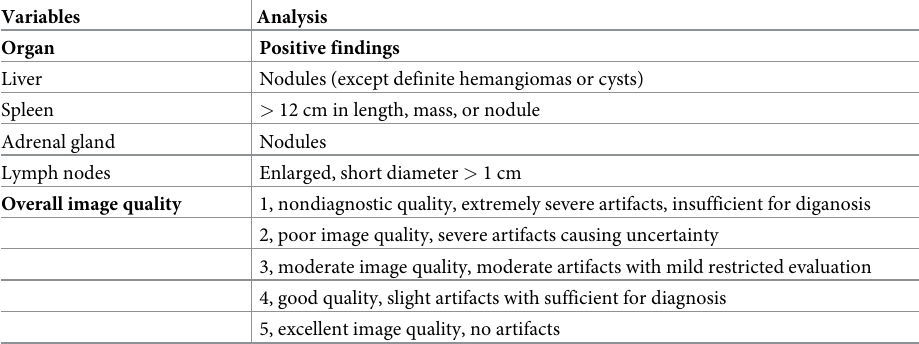
Table 2. Qualitative visual image